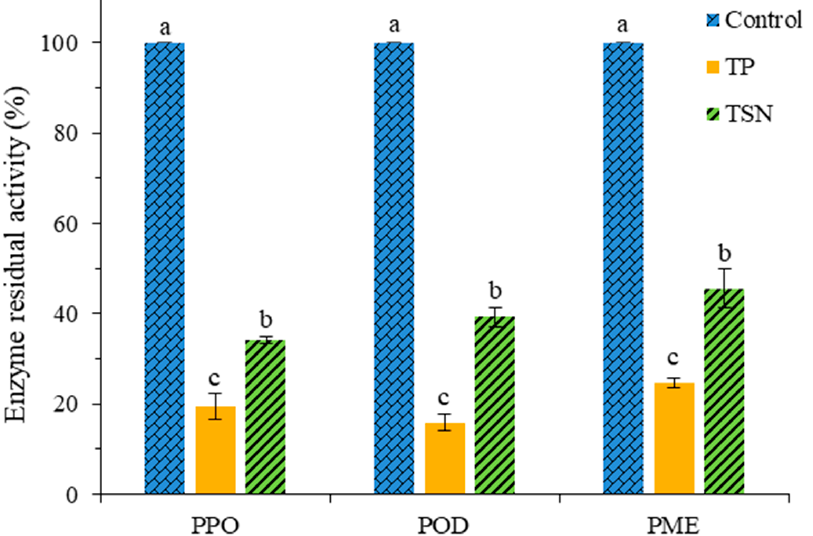
Figure 2. Passivation effects of different sterilization treatments on the enzyme activity of orange juice.